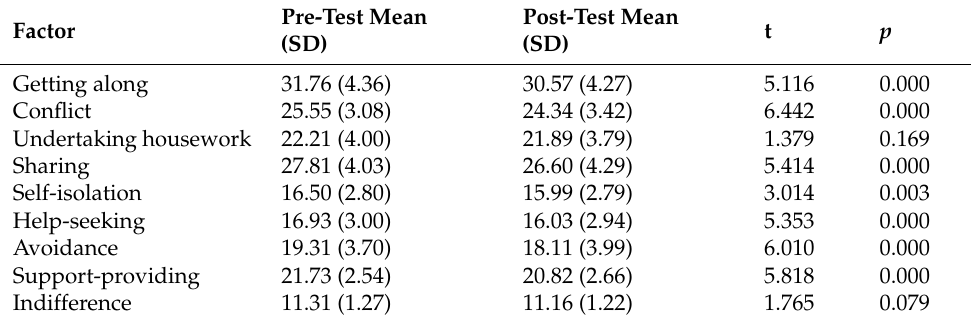
Table 4. The results of paired sample t -tests on 9 dimensions of